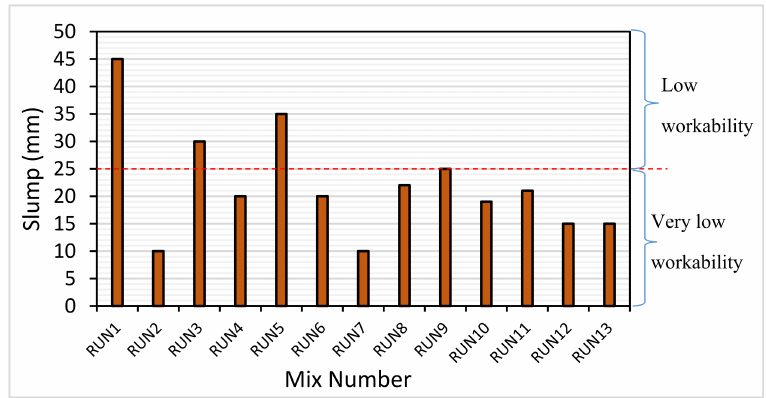
Figure 4. Slump of the